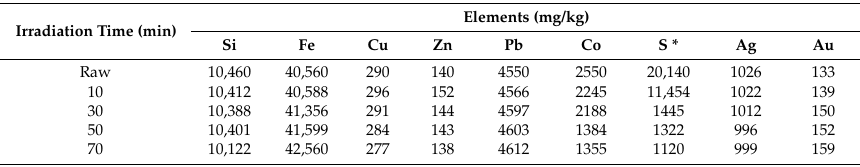
Table 2. Chemical composition of gold concentrates after the microwave treatment with different irradiation times.